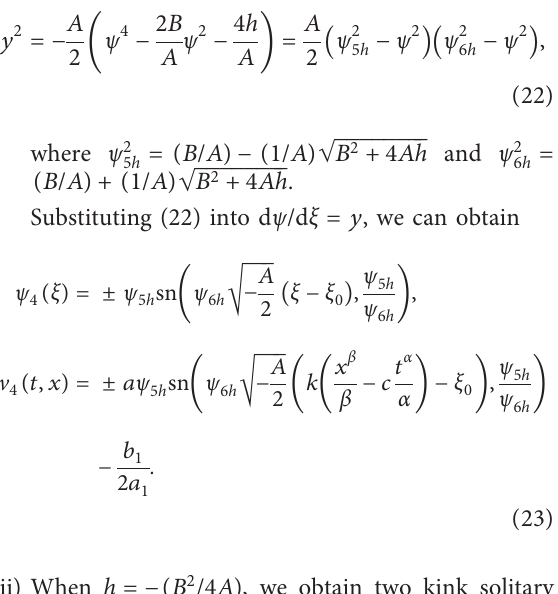
Figure 2: The bell solitary wave solution v Perspective view of the wave. (b) The wave along x